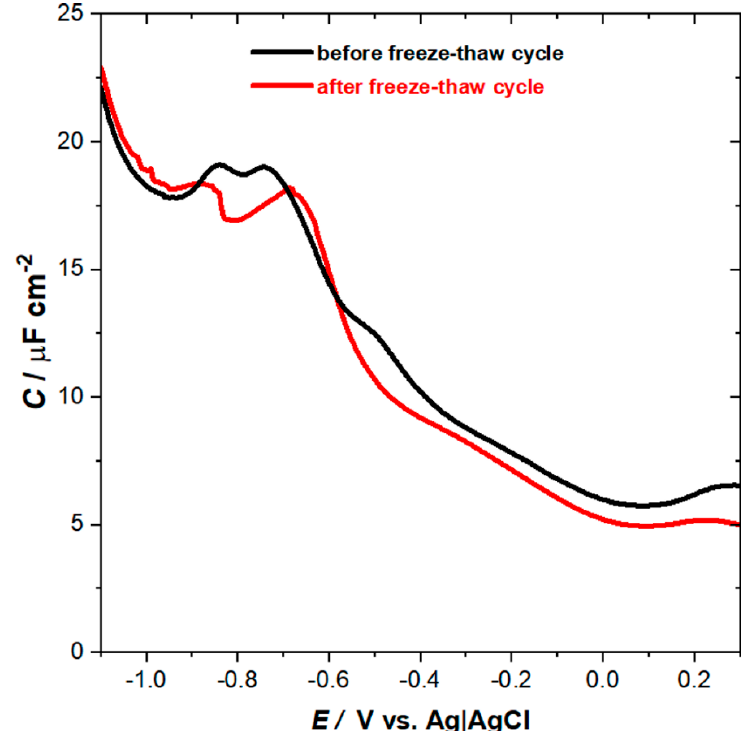
Figure 4. Potential dependence of differential capacitance of the thioglucose-modified Au(111) electrode with lipid film before (black) and after (red) one freeze–thaw cycle.